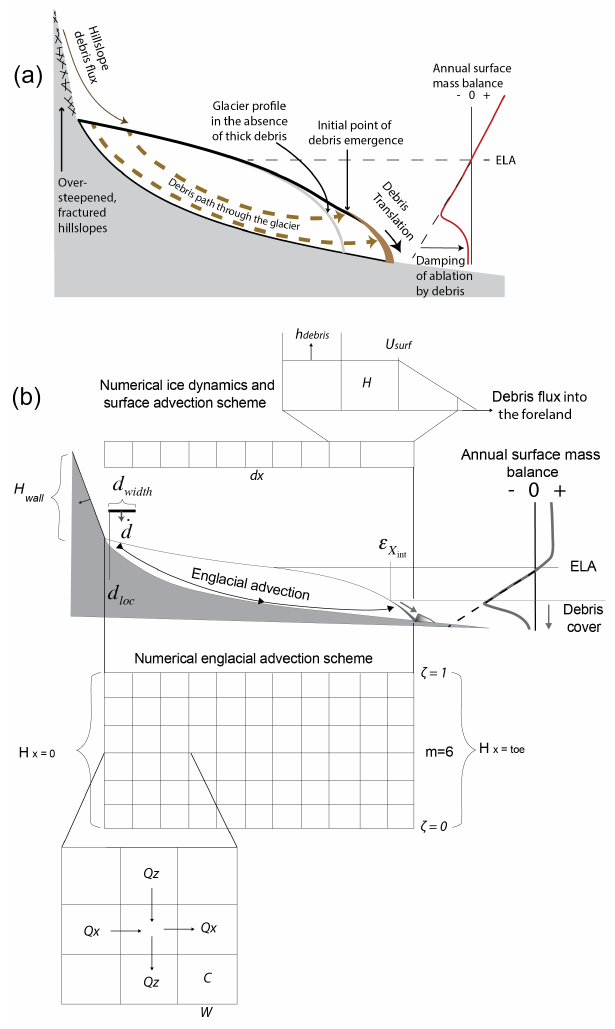
Figure 1. (a) Schematic of the debris–glacier system. Debris de- posited on or emerging in the ablation zone reduces ablation rates (above the critical debris thickness) leading to the reduc- tion in gradients of ice discharge and the lengthening of glaciers. (b) Schematic of the coupled debris–glacier model. Debris de- posited on the glacier is either advected through the glacier and/or advected down the glacier surface. Englacial debris is advected us- ing 2-D rectangular grid and coordinate transform. Ice physics and supraglacial debris advection is treated on a 1-D